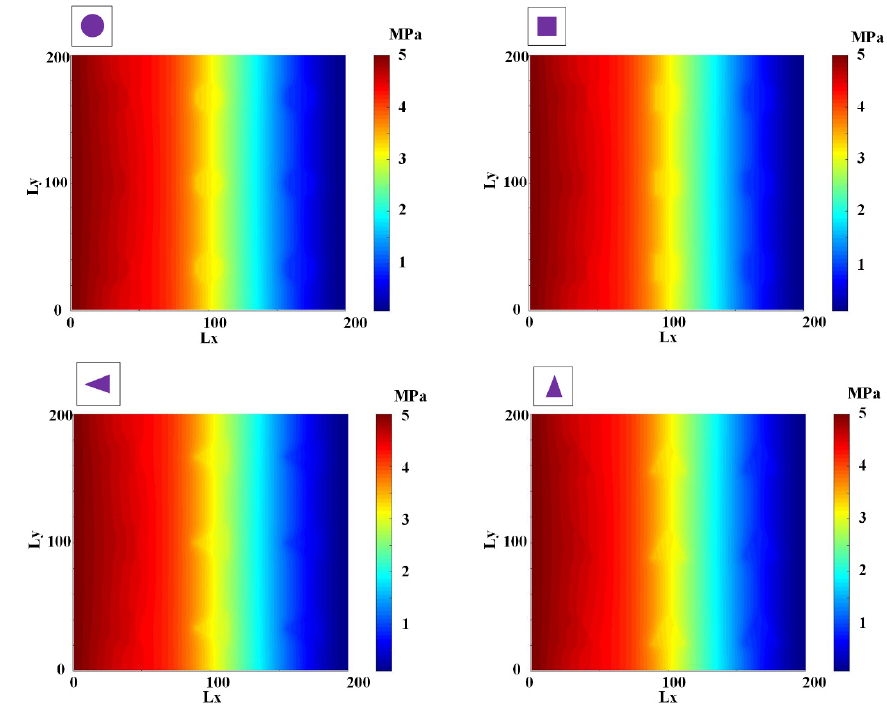
Figure 10. Fluid pressure during instroke.